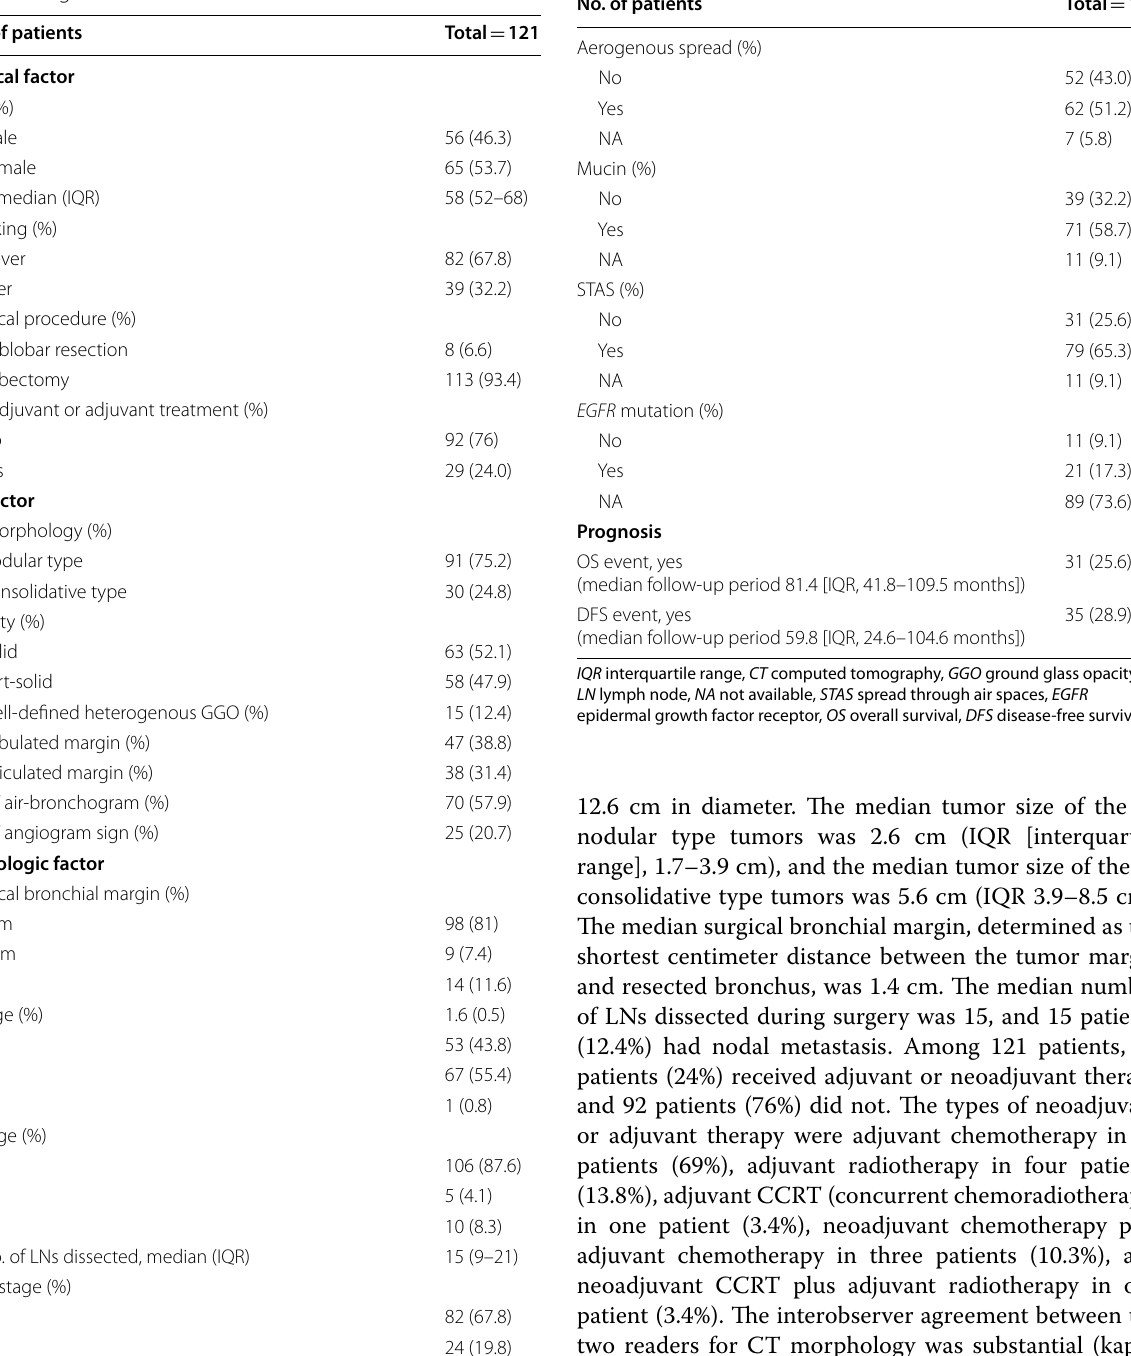
Table 1 Patient distribution according to clinicopathological and radiologic